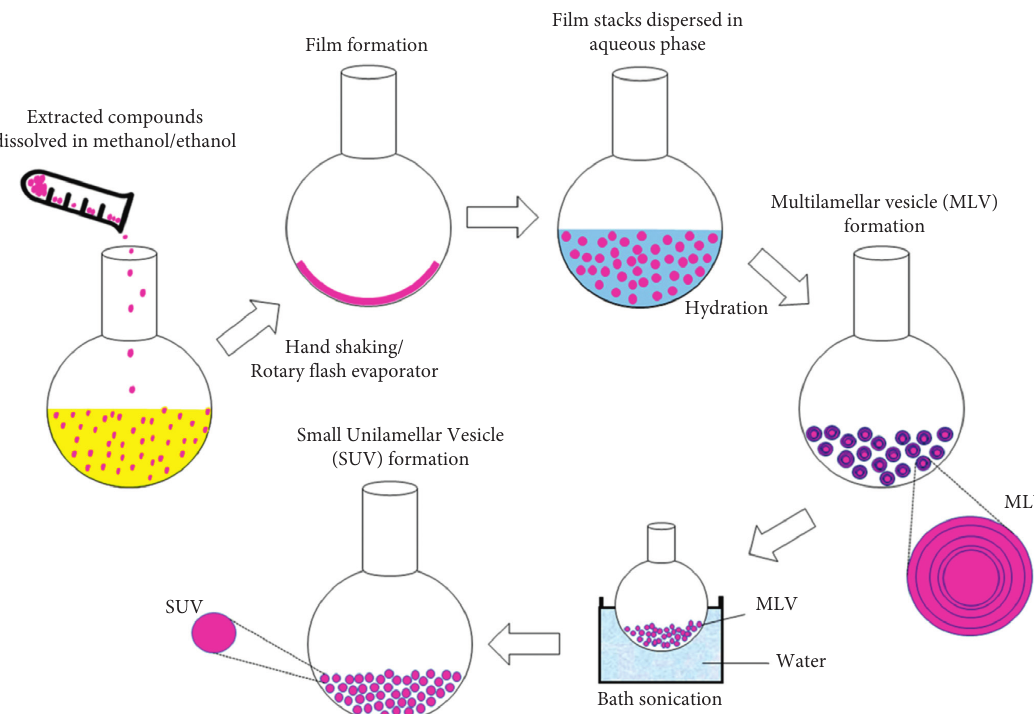
Figure 3: An illustration of the preparation process for synthesizing liposomes in a stepwise manner